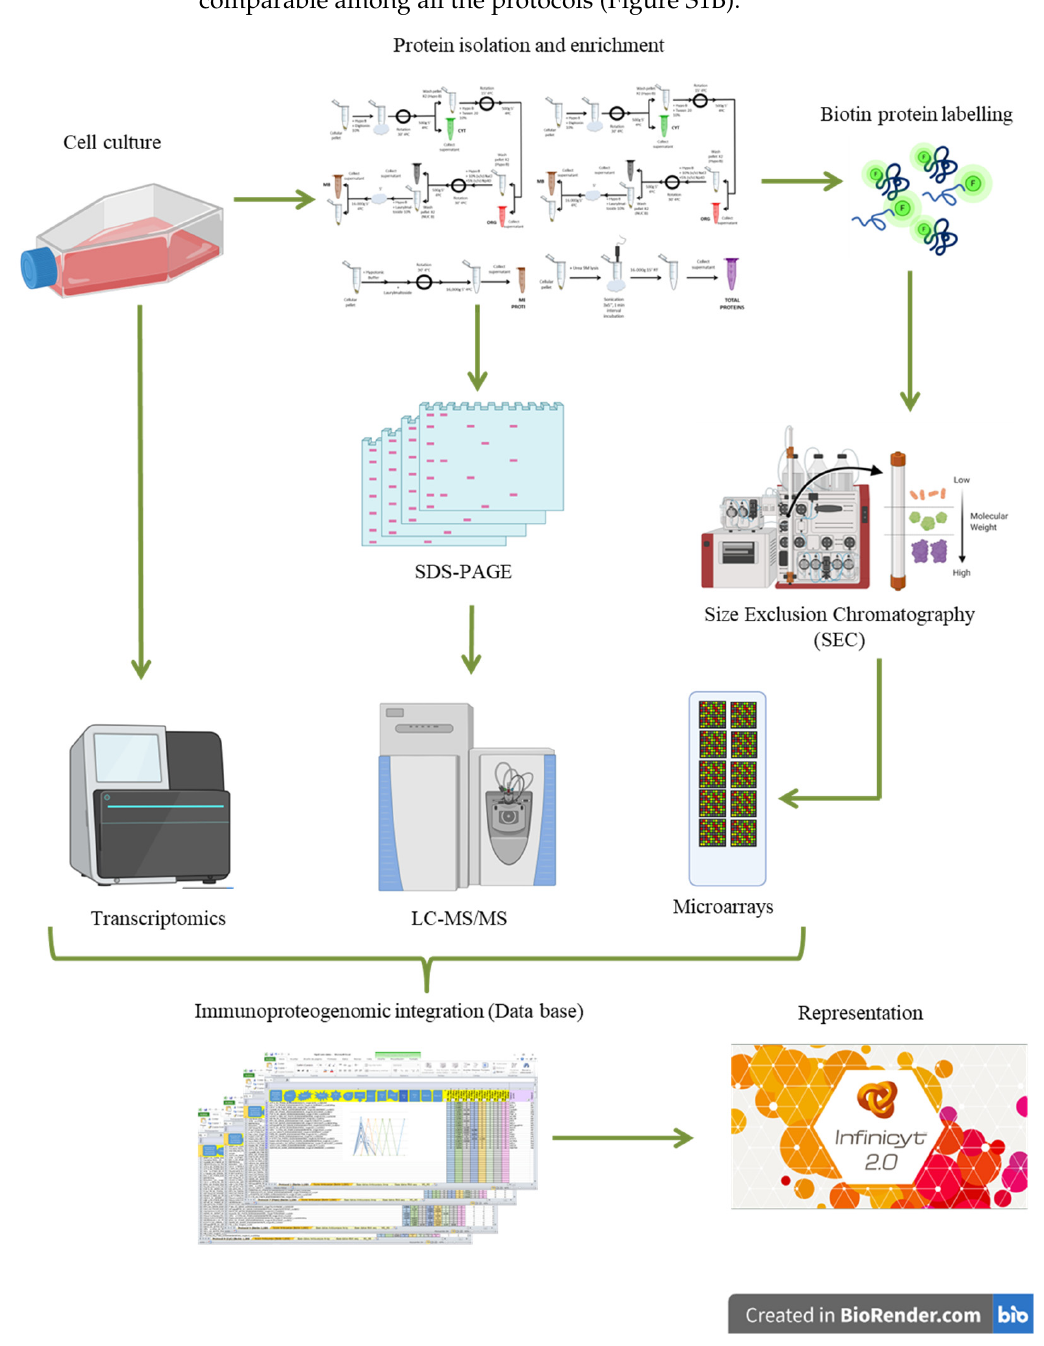
Figure 1. Schematic Representation of Experimental Design. Description of experimental steps involved for multi-omics integration.